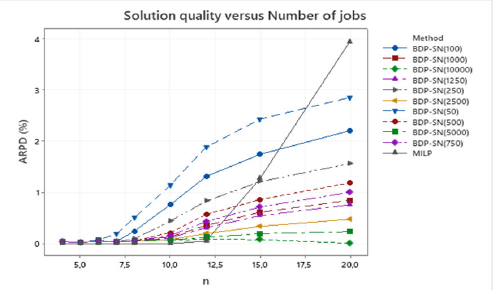
Fig. 12. ARPD variation with respect to the number of jobs for the second experimental set